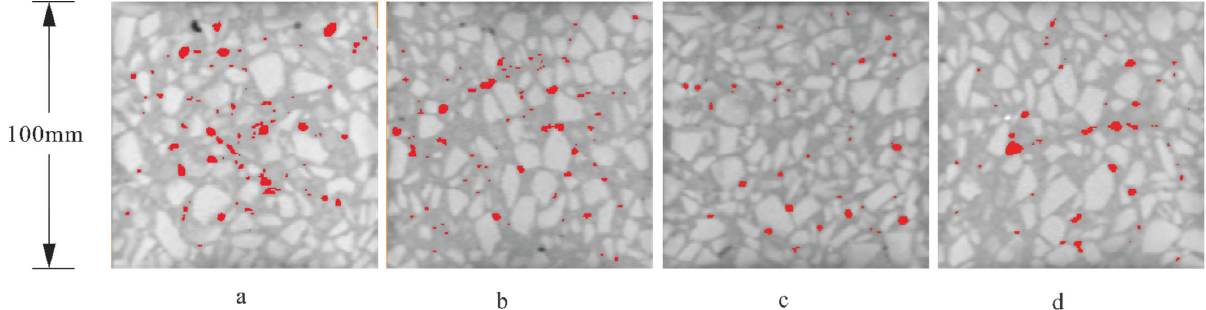
Figure 12. Scanning section CT images of different concentrations of Na 2 SO 4 in concrete ( a ) without sodium sulfate; ( b ) with 3% mixed sodium sulfate; ( c ) with 5% mixed sodium sulfate; ( d ) with 10% mixed sodium sulfate.